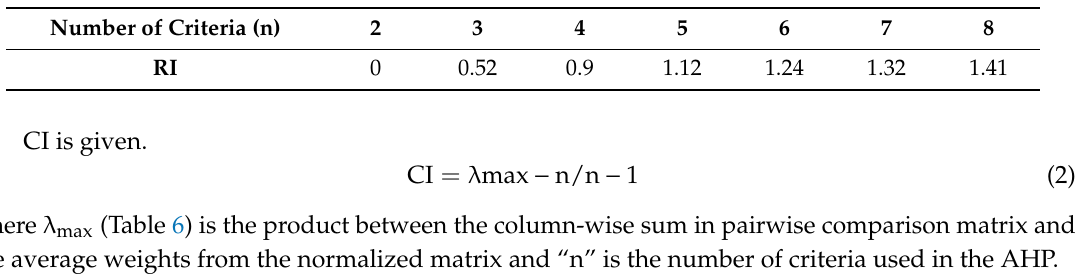
Table 5. Consistency indices for a randomly generated matrix.